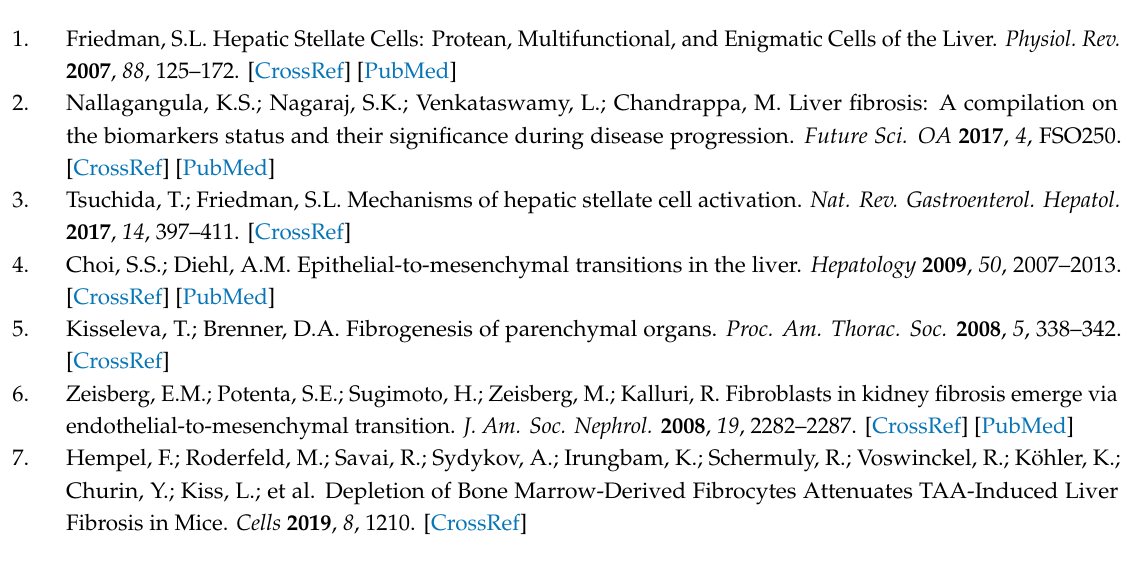
Figure S1: In vitro e ff ects of TGF β or PDGF-BB on the gene expression of markers for HSC-activities during fibrosis in LX-2 and TWNT-4 cells (both n = 4), Table S1: Ct values ± SEM per gene of the untreated controls in all used in vitro models as determined with quantitative real-time